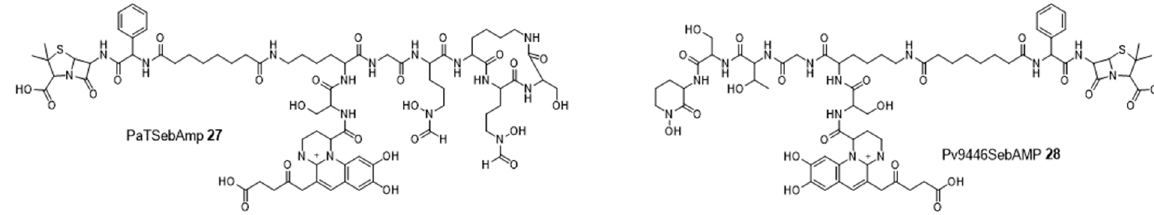
Figure 10 . Pyoverdins conjugates 27 – 28 . Figure 10. Pyoverdins conjugates 27–28 .